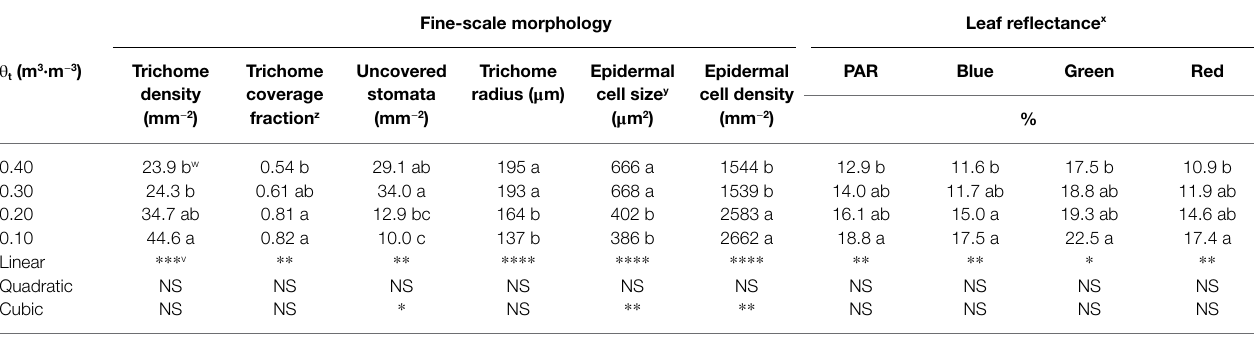
TABLE 5 | Fine-scale morphology and leaf reflectance at the wavelengths of photosynthetically active radiation (PAR), blue, green, and red light of Shepherdia ×utahensis at the substrate volumetric water content treatments ( θ t ) of 0.40, 0.30, 0.20, and 0.10 m 3 ·m − 3 . Fine-scale morphology Leaf reflectance x